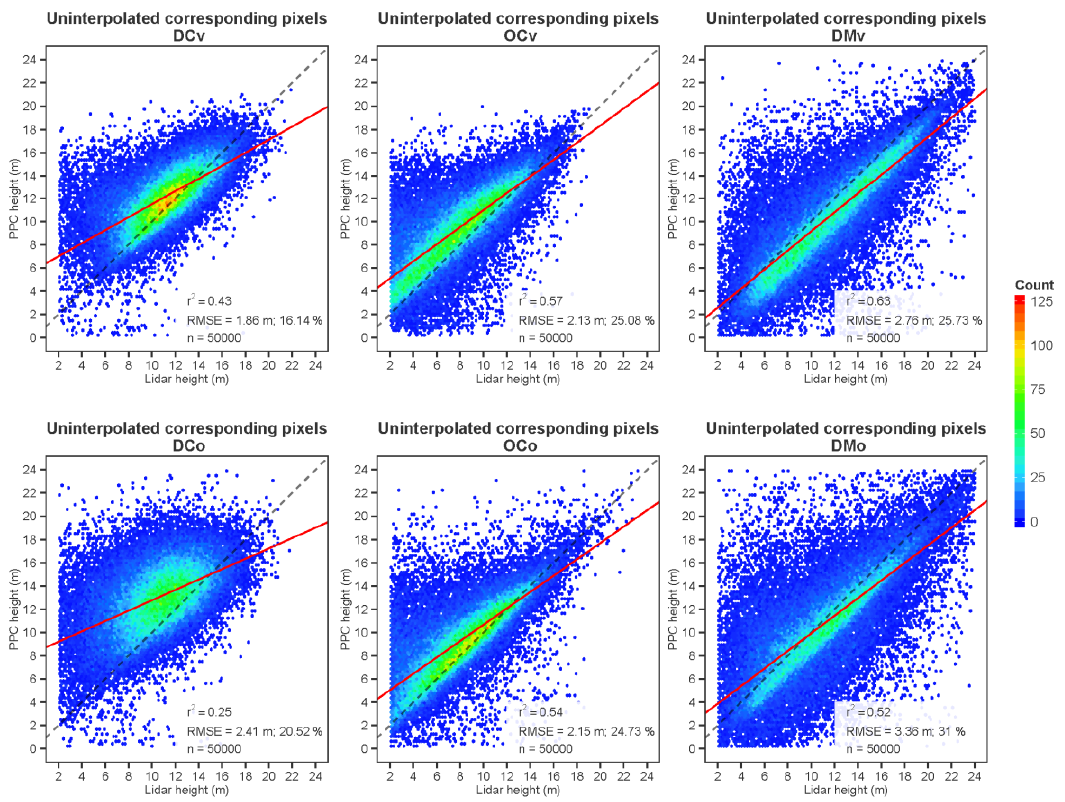
Figure 5. Scatterplots of the height correspondence between lidar and photogrammetric uninterpolated CHMs (red line represents the slope of the relationships and dashed line represents the 1:1 relationship).